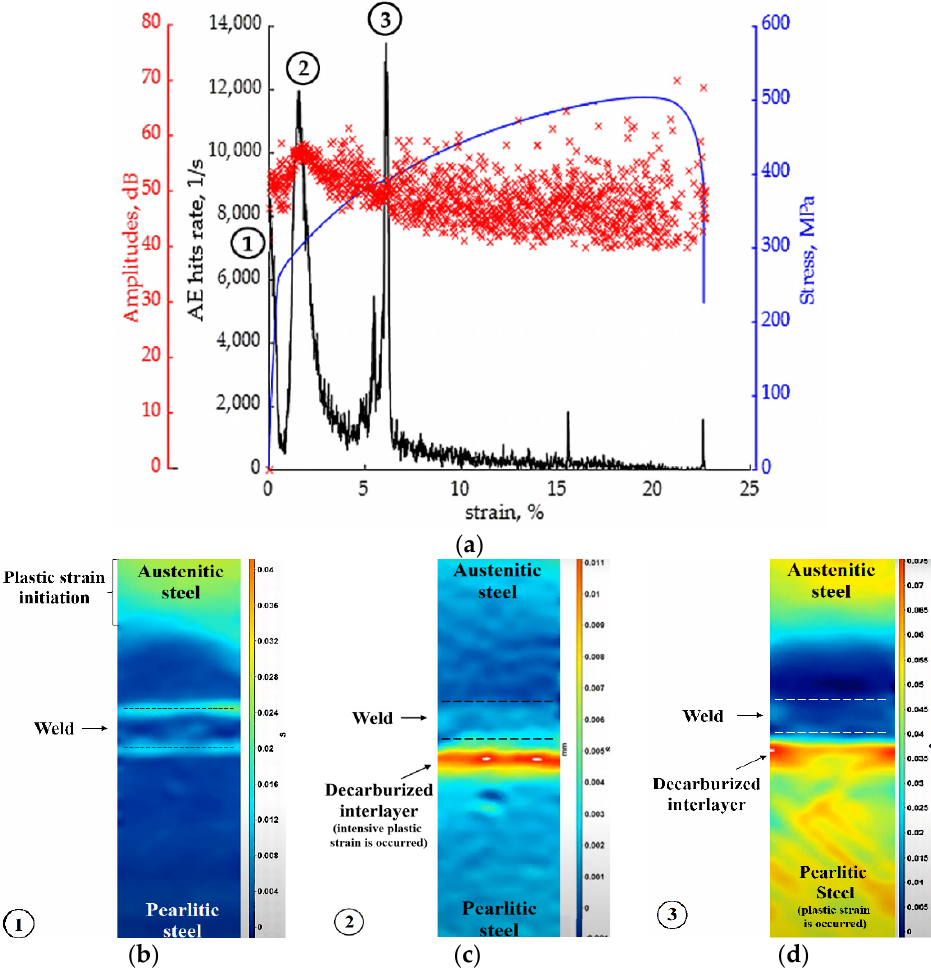
Figure 8. Results of dissimilar welded joint with diffusion interlayers test: AE data recorded under tension ( a ) and strain distributions over the painted area on different stages of test ( b – d ).